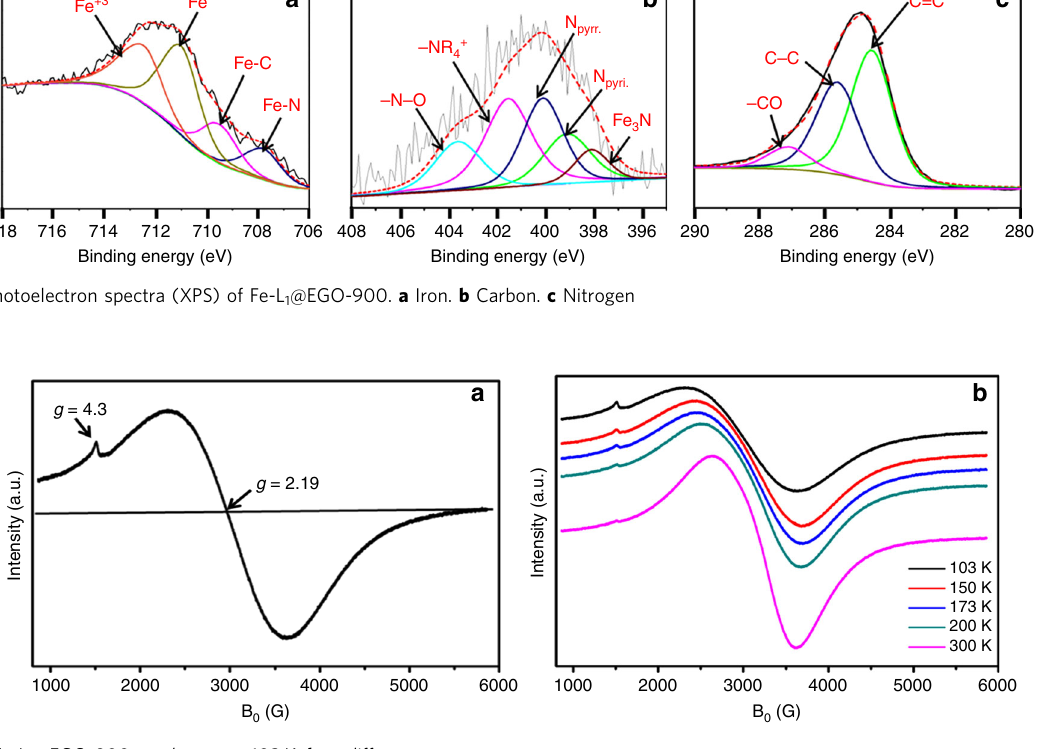
Fig. 6 EPR of Fe-L 1 @EGO-900 catalyst. a at 103 K. b at different